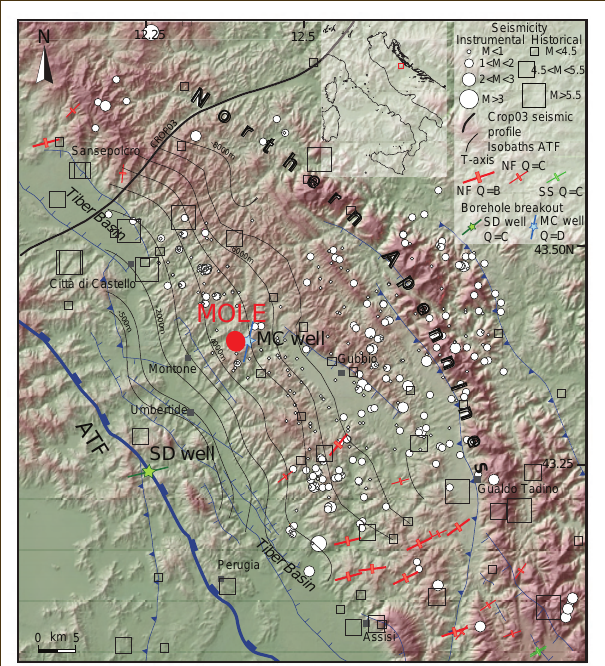
Figure 5. Digital Elevation Model around the planned MOLE borehole (red circle) showing the seismicity (instrumental from Chiaraluce et al., 2007 and historical from Boschi et al., 2000), T-axes from focal mechanisms (Montone et al., 2004), breakout data (Mariucci et al., 2008) and Alto Tiberina Fault isobaths (Mirabella,